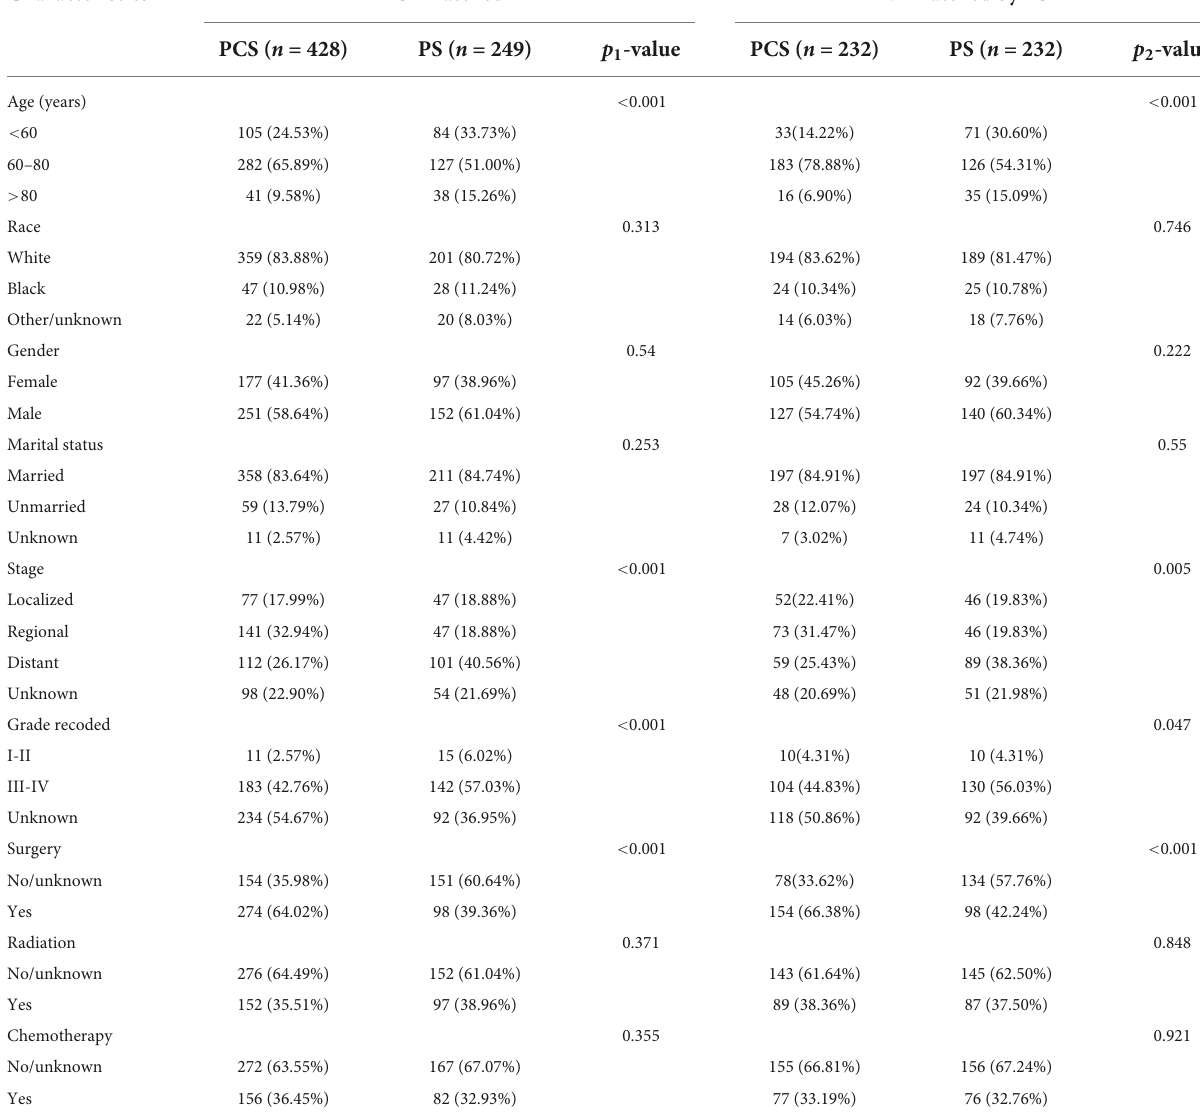
TABLE 1 Clinicopathologic characteristics of PCS and PS patients in unmatched and matched cohorts.